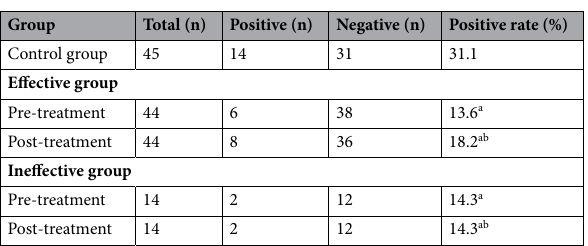
Table 4. Effect of ASA drugs on the expression of P-gp in UC. a P < 0.05 versus normal control. b P > 0.05 versus